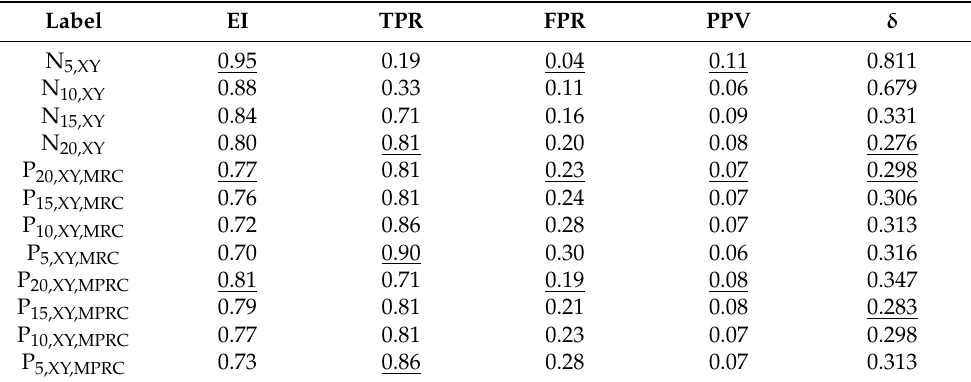
Table 9. Skill scores for the defined rainfall thresholds in XY (the best values of the scores, for each type of threshold, are